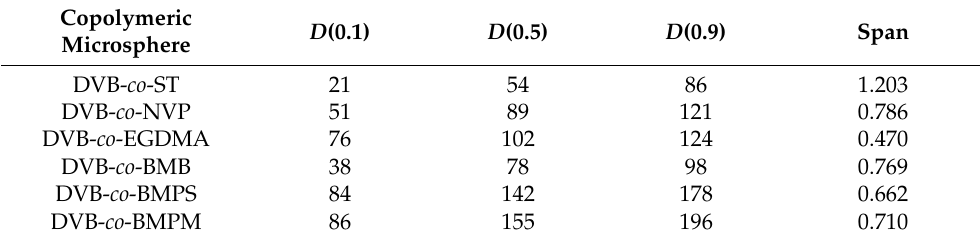
Table 2. The statistical data of particle size distribution.